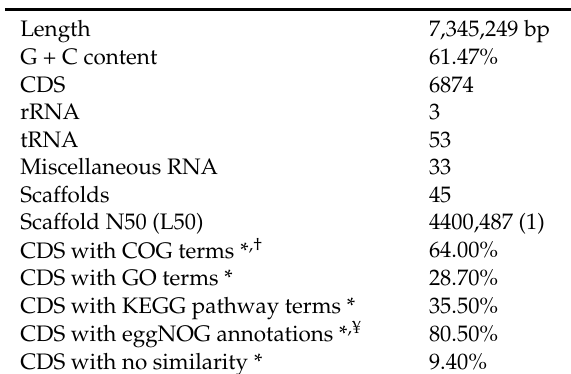
Table 1. Features of the Ensifer sp. M14 genome